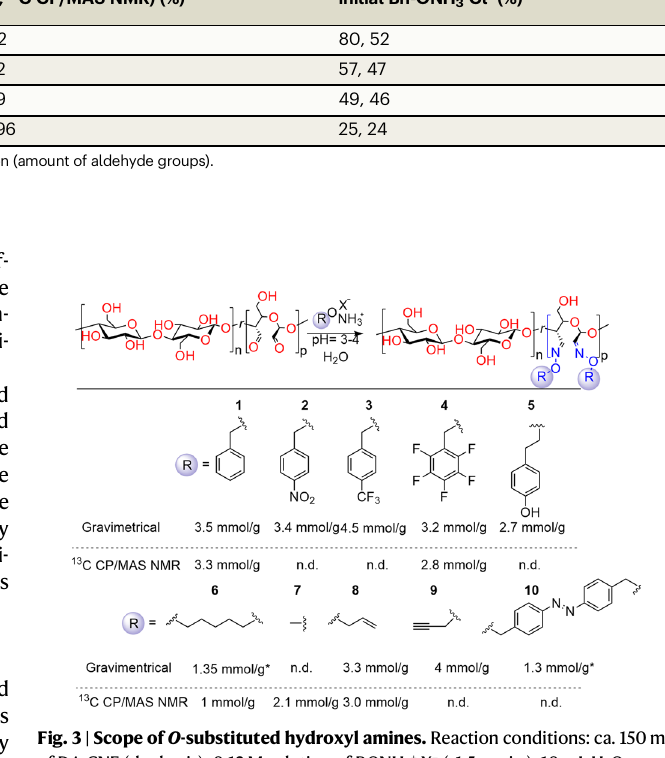
Table 2 | Optimization of reaction conditions for preparation of R-ON-CNF Entry DO Bn- DF (mmol/g) (mmol/g) ONH 3 + Cl − , equiv.